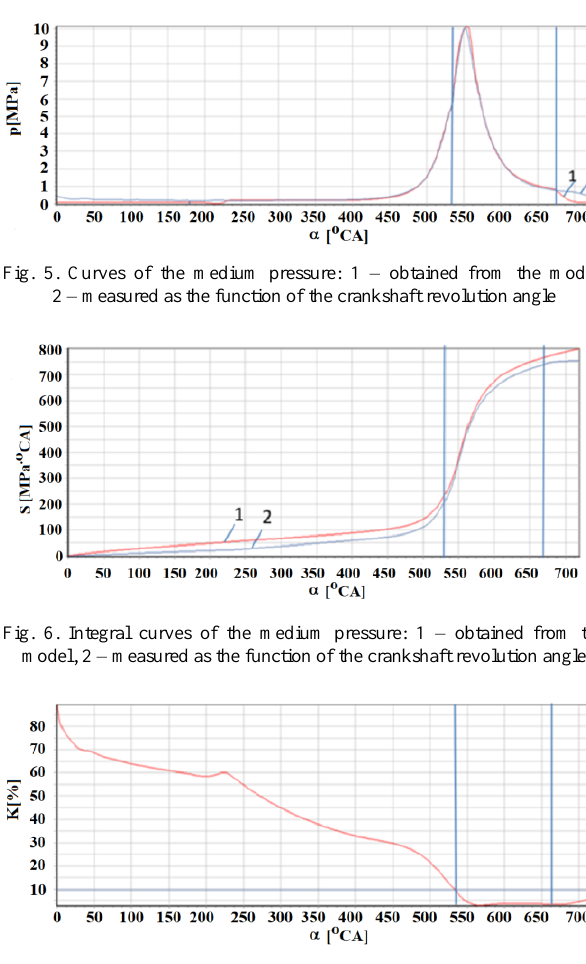
Fig. 7. The curve of the "K" parameter as the function of the crankshaft revolution